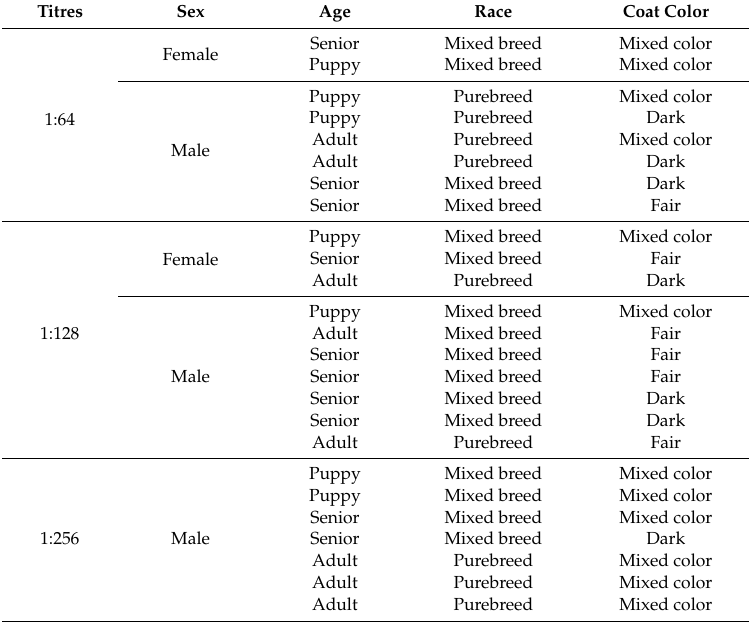
Table 1. Characteristics of dogs that showed antibodies against B. burgdorferi : titre and the four variables considered (sex, age, race and coat